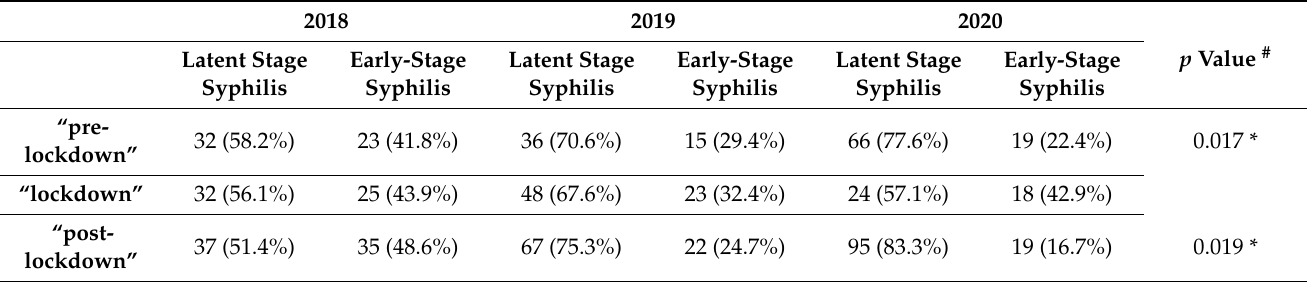
Table A3. The number and proportion (%) of patients diagnosed with latent stage syphilis and early-stage syphilis (primary and secondary syphilis) in the “pre-lockdown” (1 January–27 March), and 2020, respectively.